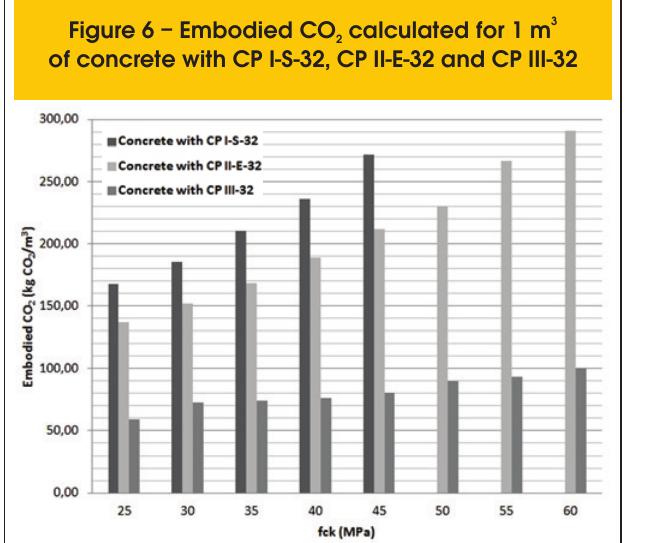
Figure 8 – Non renewable raw material content 3 Figure 6 – Embodied CO calculated for 1 m calculated for 1 m3 of concrete 2 with CP I-S-32, CP II-E-32 and CP